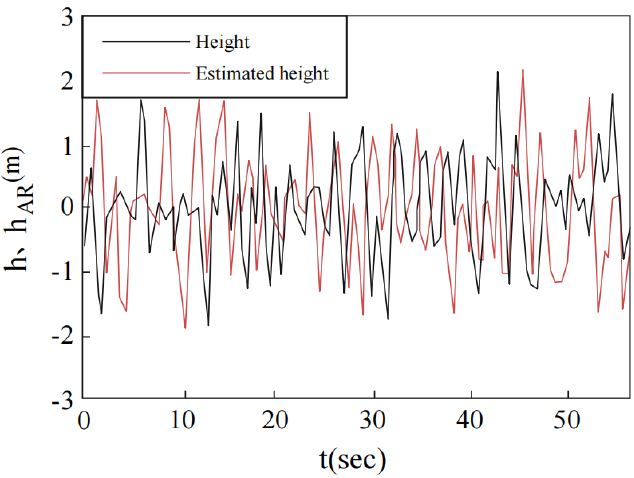
Figure 7. Height of the ideal landing point and its estimated error (encounter angle of π /3, level − 5 sea state, navigation speed of 18 knots).